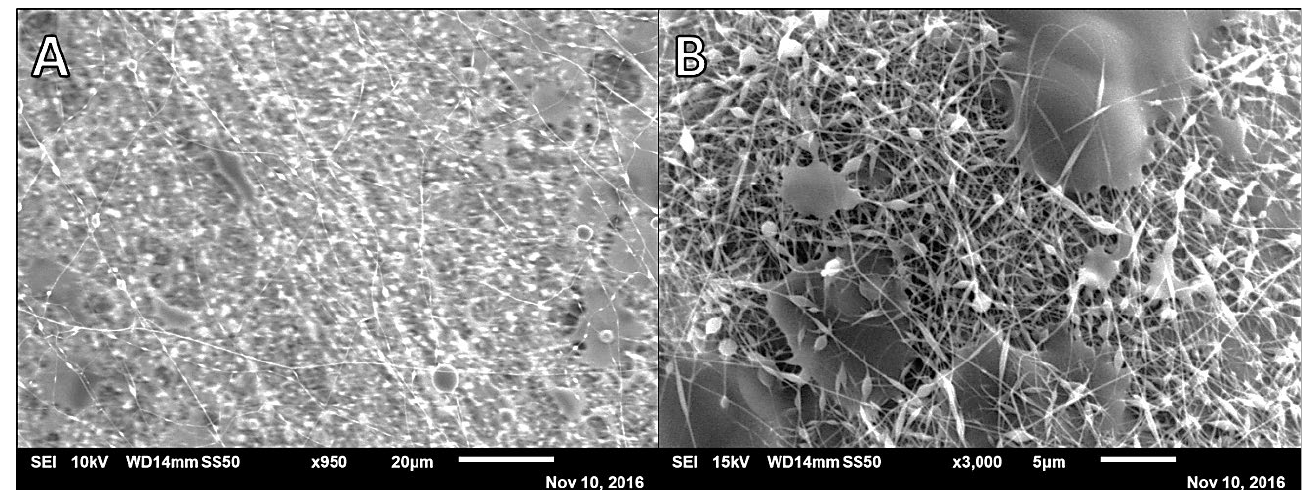
Figure 1. Scanning electron microscopy (SEM) micrographs of 7:3 2% alginate (Alg):10% poly(vinyl alcohol (PVA) at different magnifications; average diameter = 157.9 nm, SD = 43.1, n = 40. ( A ) × 950 and ( B ) × 3000 at 5.8 μL/min, 18.5 kV, 90 mm, and 2 mL dispensed (disp).